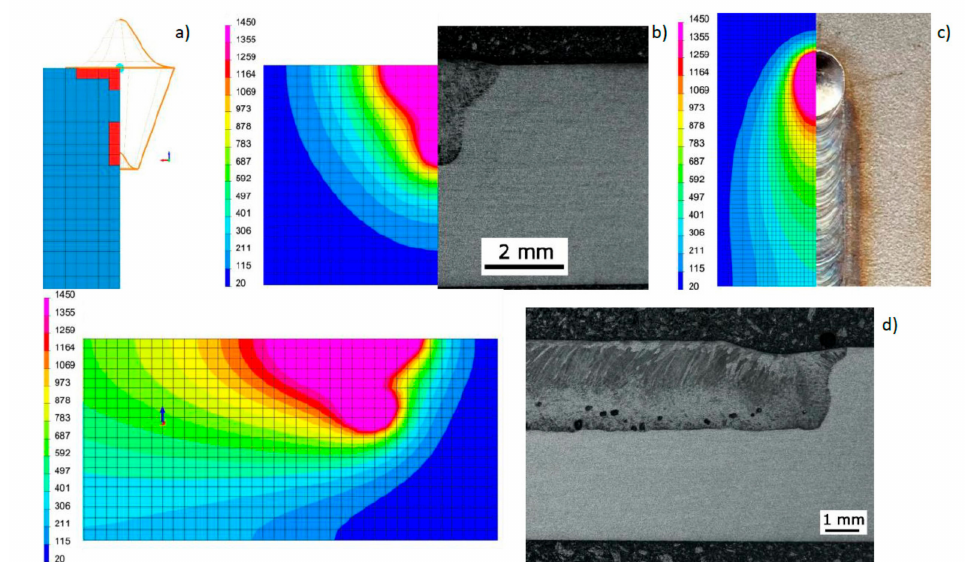
Figure 12. View ( a ) of the method of loading the mesh elements and placement of the conical model of the heat source, comparing ( b ) the shape of the bead on the cross-section, ( c ) the shape and size of the weld pool, and ( d ) the longitudinal section of DL_T1 test bead with the results of numerical analyses (Tables 3 and 4).